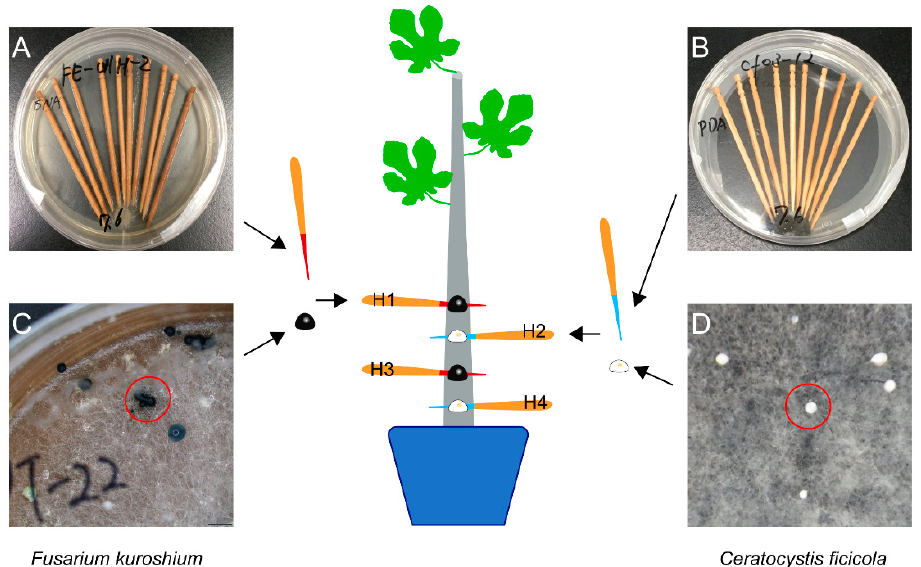
Figure 2. The dual inoculation of both Fusarium kuroshium (H1 and H3) and Ceratocystis ficicola (H2 and H4) on the fig saplings. ( A ) Toothpicks with hyphae of F. kuroshium ; ( B ) toothpicks with hyphae of C. ficicola ; ( C ) F. kuroshium with the greenish conidial masses (red circle); ( D ) C. ficicola with buff-yellow ascospore masses (red circle).